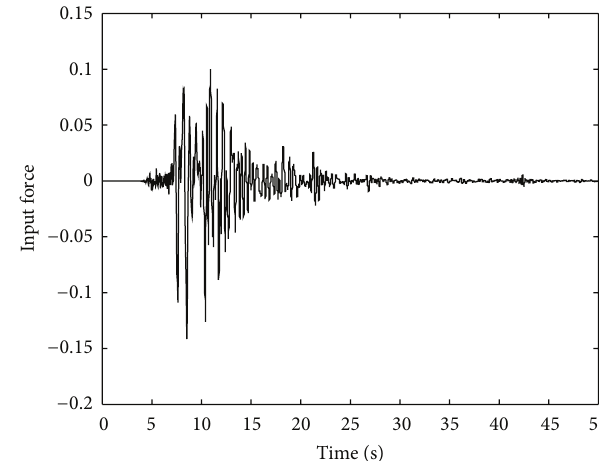
Figure 1: Ground acceleration